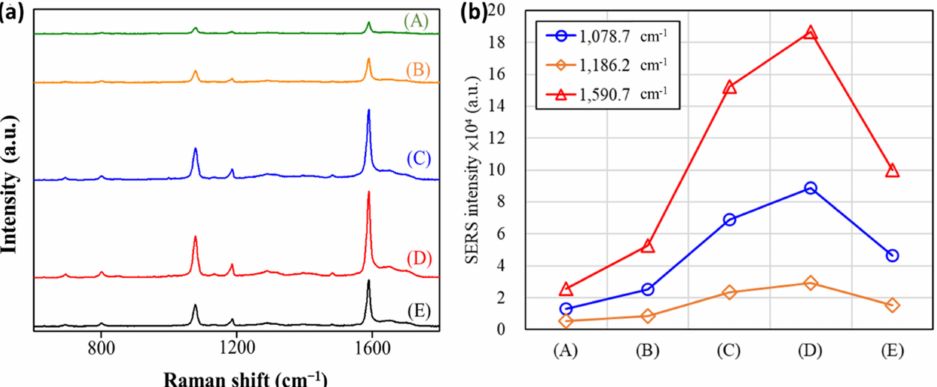
Figure 9. ( a ) Raman spectra of aqueous solutions of 4-MBA molecules (10 − 6 M) on various Au@Ag-DNFs/Si substrates with the following ratios: (A) 250/0, (B) 190/60, (C) 125/125, (D) 60/190, and (E) 0/250 with an acquisition time of 0.5 s each. ( b ) 4-MBA SERS intensity peaks for various samples. The wavelength of incident light is 532 nm with a power of 0.1 mW focusing in a 700 nm spot-width while Raman scattering signal accumulation time of 0.5